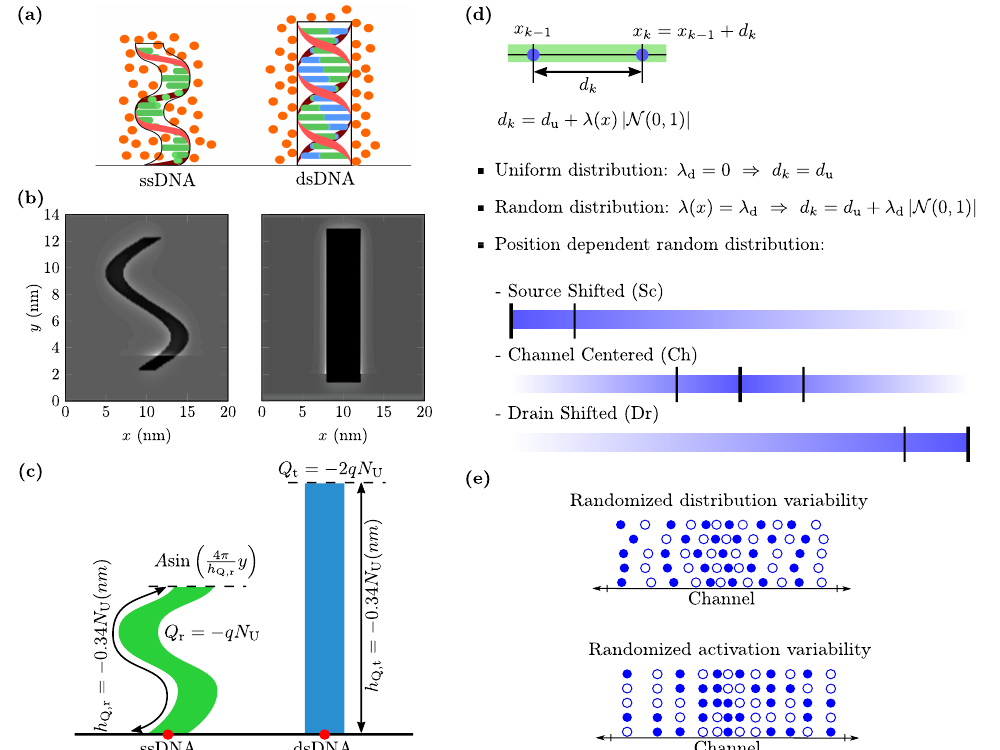
Figure 1. ( a ) Models for the ssDNA (receptor) and dsDNA (receptor-target complex) molecules. ssDNA model considers a sinusoid-shaped charged region where ions are allowed to enter, while the dsDNA model considers a box-shaped region where ions cannot penetrate. ( b ) Examples of simulated ion distributions regarding idle and activated DNA receptors. ( c ) Mathematical modeling of the length, shape and charge of ssDNA and dsDNA receptors. In both cases, the length of the molecule h Q and its charge Q is scaled with the number of nucleotides N U . ( d ) Location of receptors, controlled with the distance between them (for the k -th receptor, d k = x k − x k − 1 ). That distance is considered constant (uniform distribution) or defined by a half-normal distribution with a position dependent variance. This latter enables the definition of densely occupied regions at the sensing interface, allowing one to choose between the three distributions indicated by the blue bars. ( e ) Example of 5 channel-centered (Ch) distributions with P = 50%, where filled and empty circles represent activated and deactivated receptors, respectively. Randomized distribution variability: considering a fixed activated receptor configuration (one occupied—one empty), several distributions are